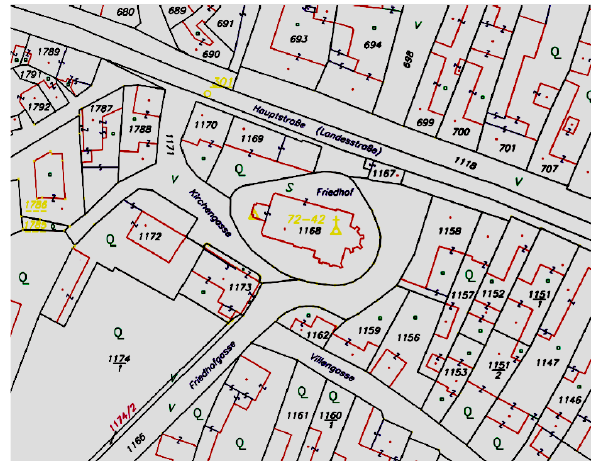
Figure 1. Example of the Austrian digital cadastral map